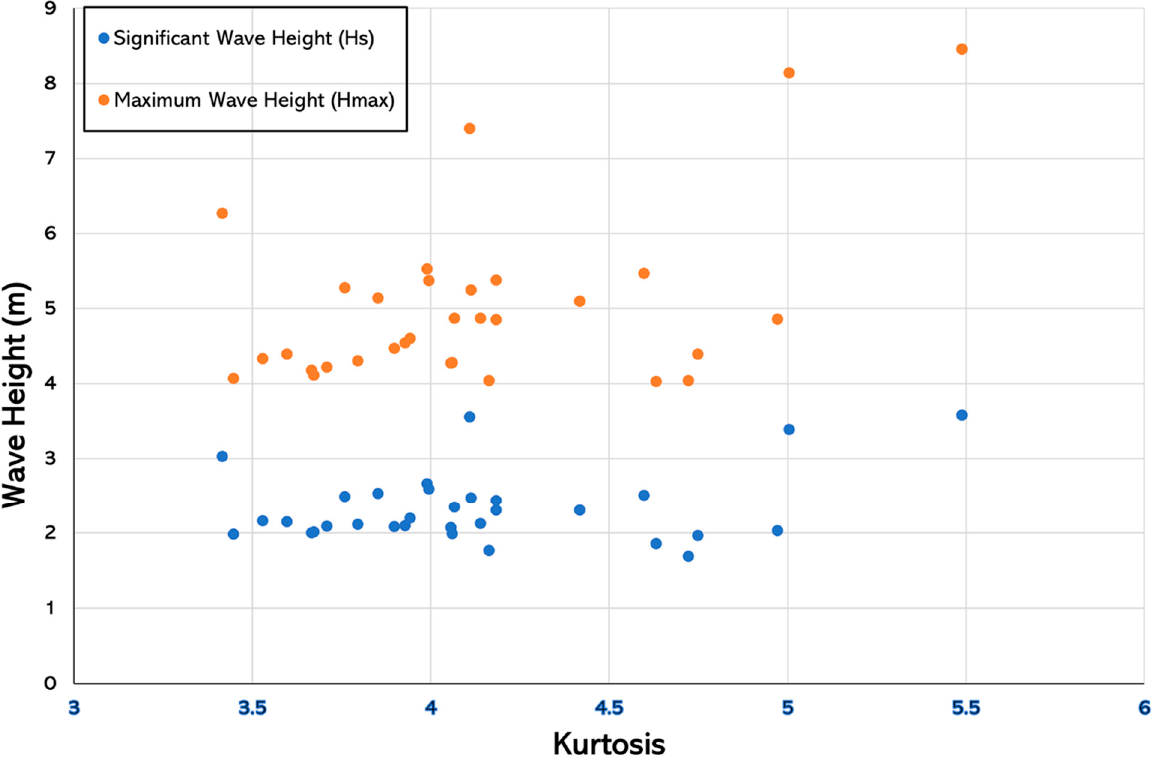
Figure 7. The kurtosis values of the 32 rogue waves that were higher than 4 m versus wave height. H s is in blue and H max is in orange. All points were above the kurtosis value of 3.4.